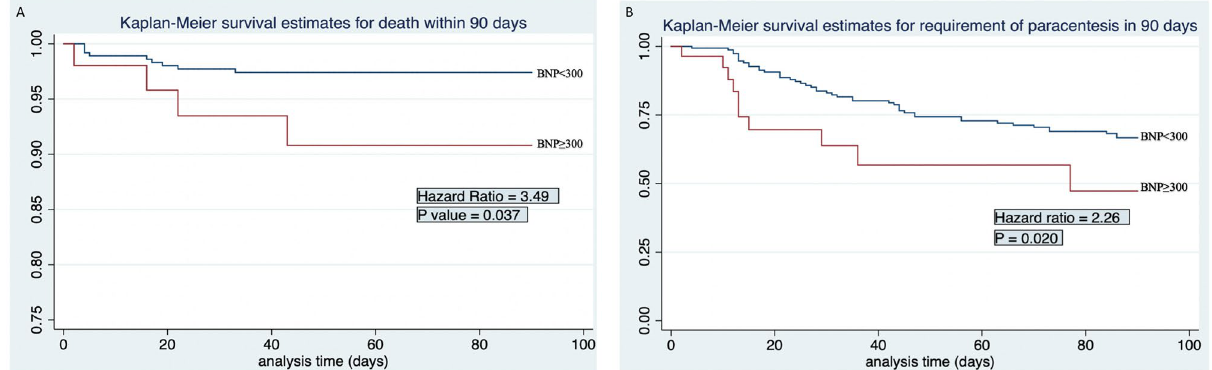
Figure 1. A Kaplan–Meier curve comparing 90-day mortality between BNP < 300 and BNP ≥ 300. B Kaplan– Meier curve representing 90-day paracentesis requirement based on BNP